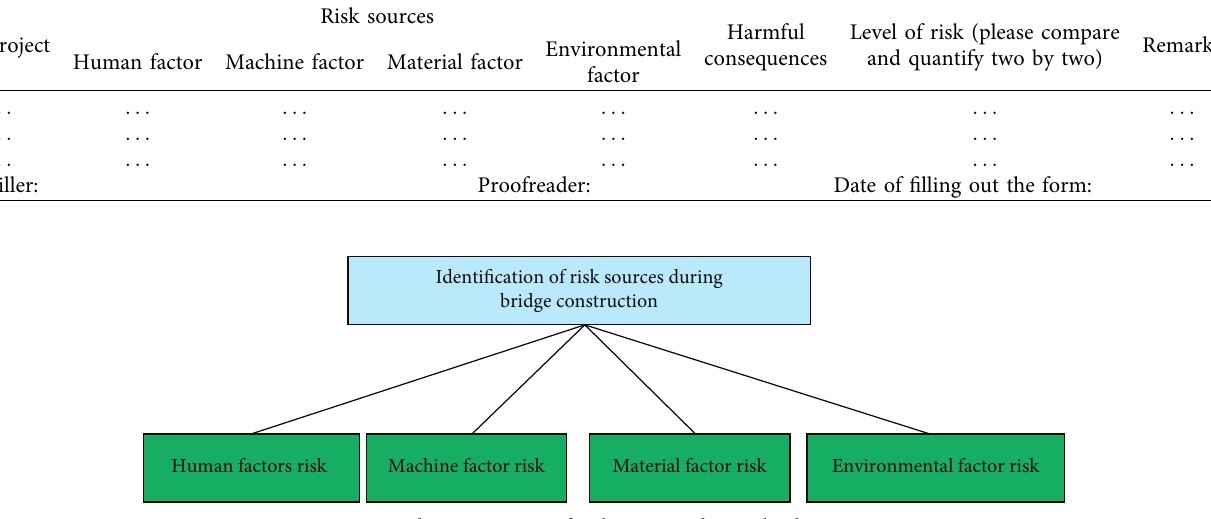
Table 2: Questionnaire on safety risk sources during bridge construction.